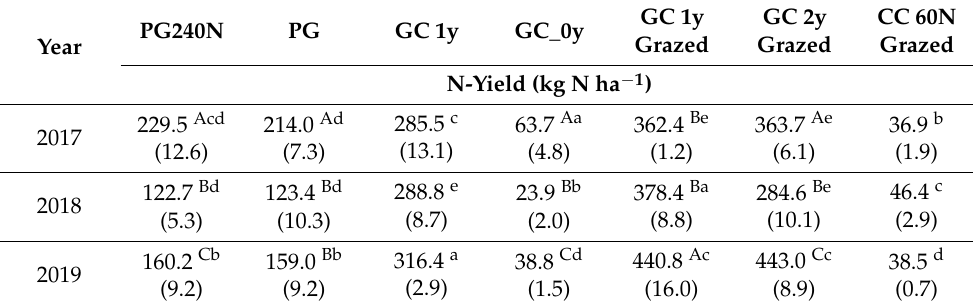
Table 4. The N-yields (kg N ha − 1 ) of the different sward types investigated over the three years (2017, 2018 and 2019). Different upper-case letters indicate significant inter-annual differences. Different lower-case letters indicate significant differences between the various sward types. SEM are shown in brackets.